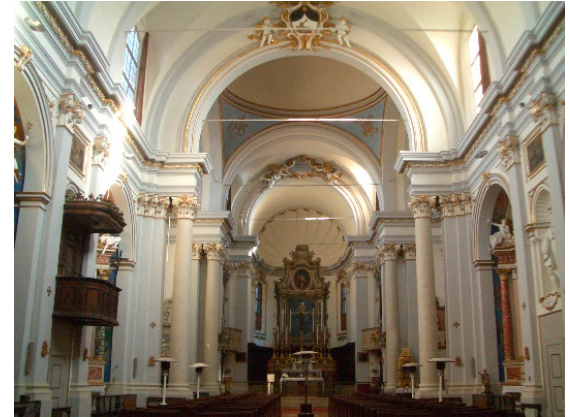
Figure 1. Church of S. Dominic of Imola.